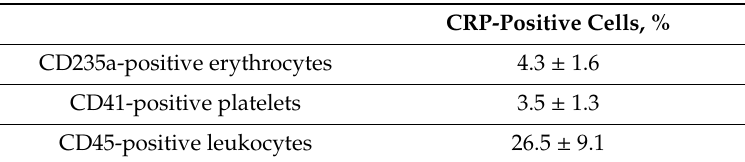
Table 1. CRP-positive cells.